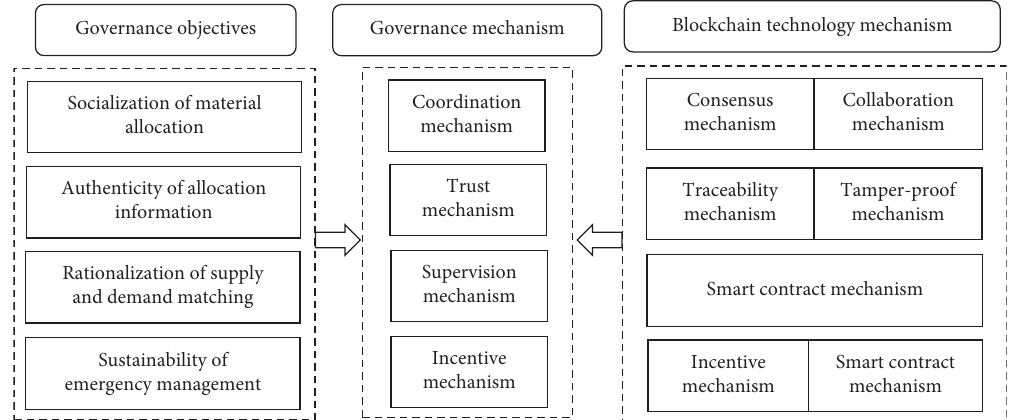
Figure 12: Emergency supply allocation governance system based on